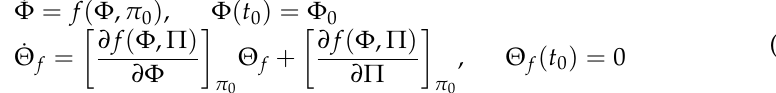
Table 5. The following initial conditions for the numerical solution of (22) are